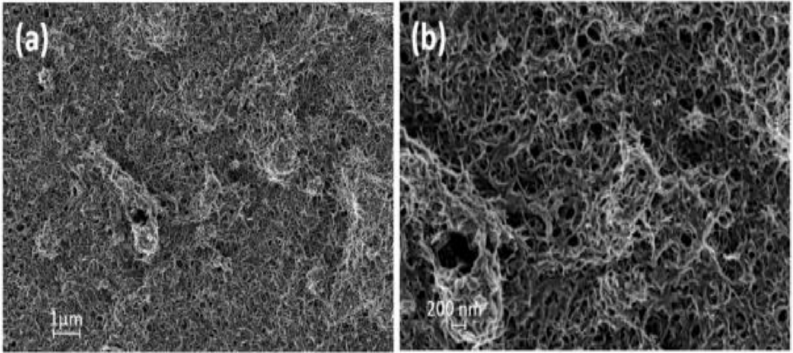
Figure 3. HRSEM images of the PANi grafted CNT sample showing ( a ) 1 µ m membrane pore size, ( b ) 100 nm membrane pore size